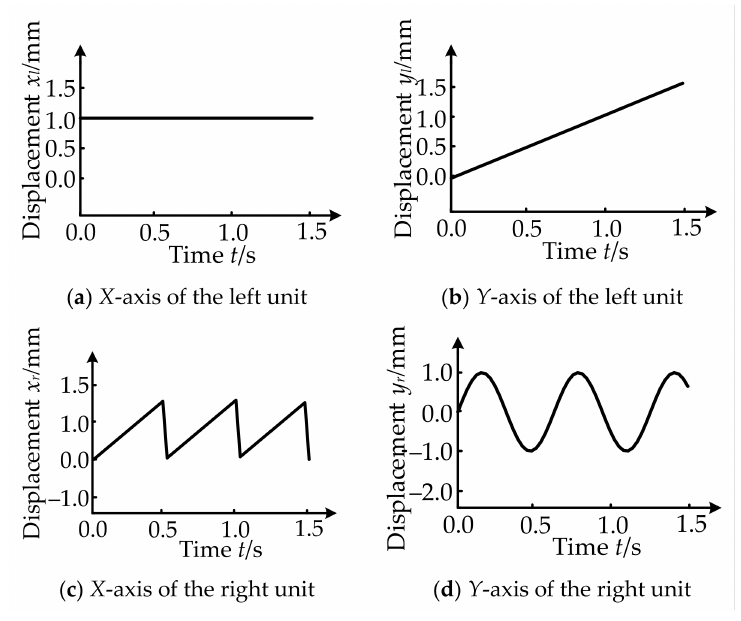
Figure 12. Input signal. The output response of the decoupled system is shown in Figure 13.